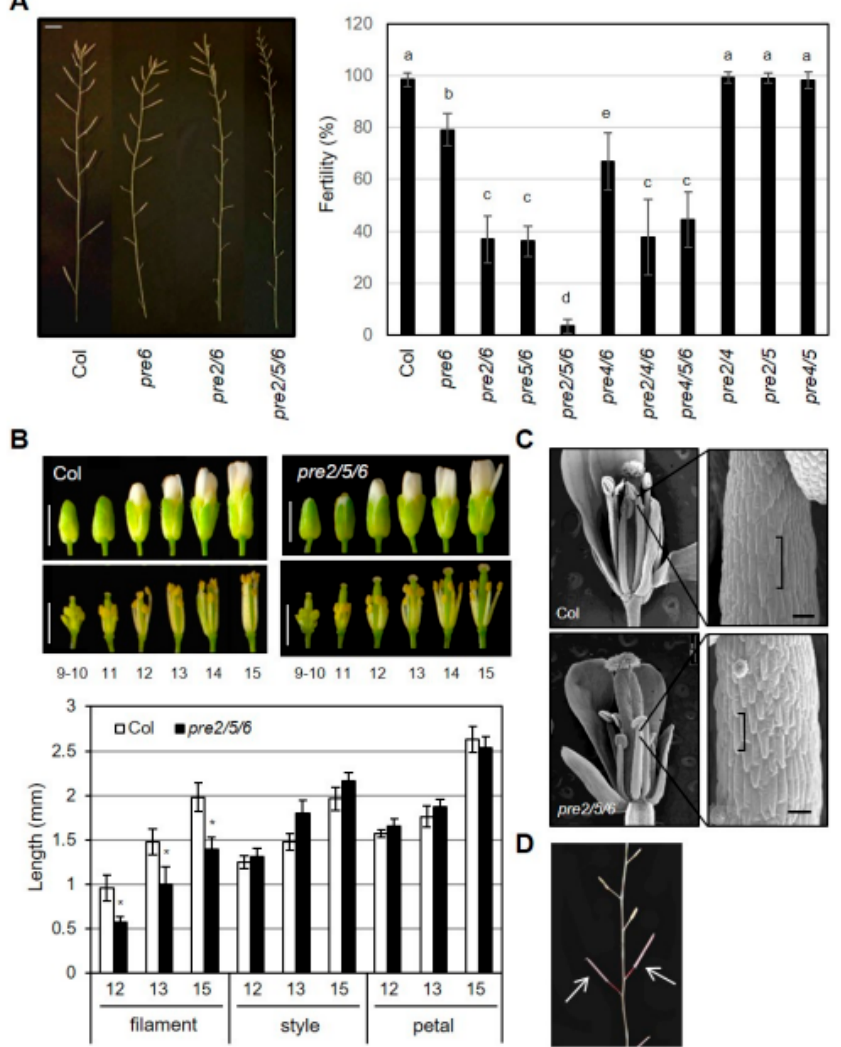
Figure 2. High order loss-of-function PRE s causes sterility. ( A ) Fertility of pre mutants. Primary inflorescence (left) and fertility of pre mutants (right). The fertility was measured as the percentage of mature siliques per whole siliques of the primary inflorescence. Values are mean ± SD ( n = 13–15). Significant difference among wildtype (Col) and mutants are indicated with letters (ANOVA, Tukey HSD test, p < 0.01). Scale bar, 5 mm. ( B ) Floral organ growth of wildtype (Col) and pre2pre5pre6 during flower development. Upper, Representative flower morphology at indicated flower developmental stages. Scale bar, 1 mm. Lower, The length of the filament, style, petal was measured at indicated flower developmental stages. Values are mean ± SD ( n = 15). Asterisk indicates significant difference from wild type ( t -test, * p < 0.01). ( C ) Reduced cell size in pre2pre5pre6 anther filament. Scanning electron microscopy was performed on anther filament from flowers at stage13. Brackets indicate the lengths of single epidermal cells of anther filaments. Scale bar, 100 μ m. ( D ) Restored fertility of pre2pre5pre6 by self-pollination. The pre2pre5pre6 flowers which were manually pollinated with their pollens produced fully mature siliques, as indicated by arrows.